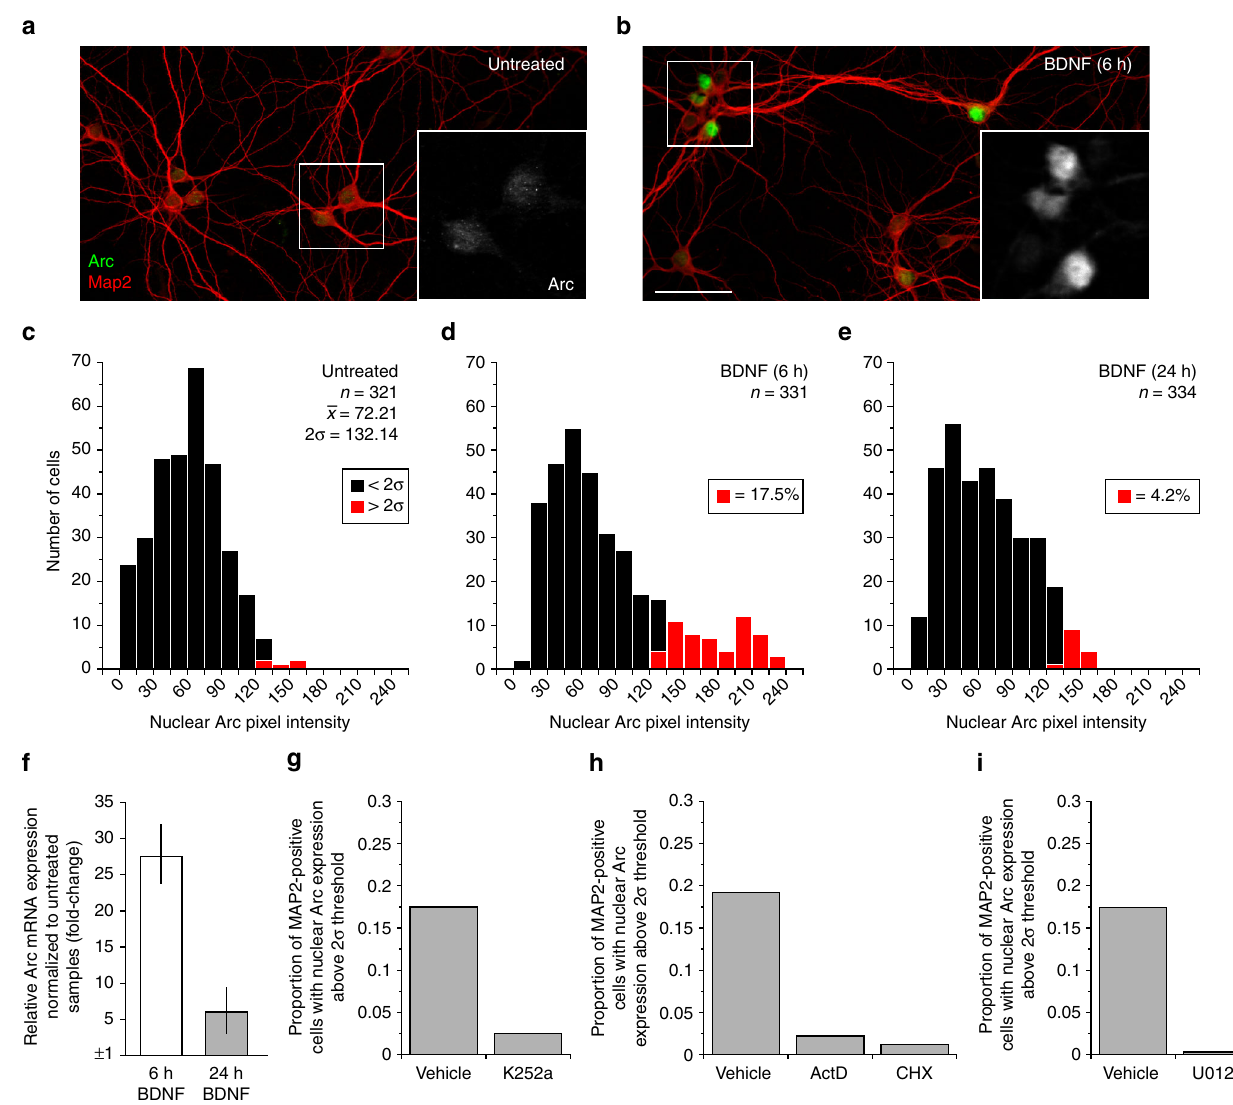
Fig. 2 Validation of a high-content image-based nuclear Arc assay adapted for high-throughput chemical screening. a , b Representative immunostaining of Arc (green fl uorophore) in untreated DIV14 mouse primary cortical neurons ( a ) and cells that were treated with BDNF for 6 h ( b ). Cells were co-immunostained with the neuronal marker Map2 (red fl uorophore) to con fi rm speci fi city of staining to neurons. The high-magni fi cation bottom-right insets in each panel show that Arc immunostaining in a BDNF-treated culture is particularly abundant in the nuclear compartment at this time point. Scale bar 50 µ m. c – e Quanti fi cation of a set of biological replicates (triplicates) reveal that 17.5% of neurons (Map2-positive cells) have above threshold nuclear Arc expression (equal to or above 2 σ of average nuclear Arc pixel intensity) 6 h after application of exogenous BDNF but only 4.2% after 24 h. f Quantitative real-time PCR Arc mRNA analysis shows a consistent difference as in d , e between cortical neurons treated for 6 and 24 h. Bars represent mean fold-change measured by RT-qPCR (error bars indicate range from three biological replicates). g – i BDNF-induced nuclear Arc protein expression is blocked by the co-application of a pan-inhibitor of receptor tyrosine kinases (k252a, 100 nM), RNA transcription (actinomysin D (ActD), 2 ng ml − 1 ), a large-scale, image-based